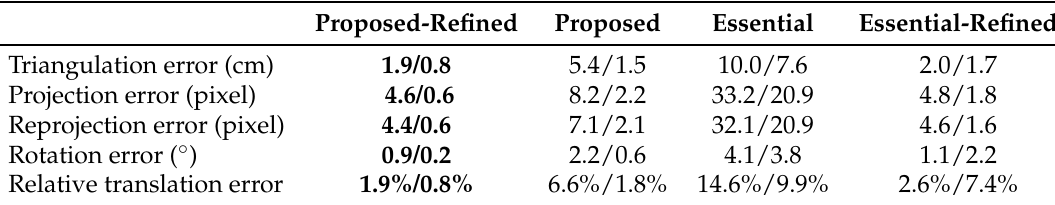
Table 2. Comparison of robustness against the uncertainty of detecting the head and feet in the image between our method (proposed) and the method of Hödlmoser et al. [17] (essential). The numbers are listed as “a/s”, where a is the average and s is the standard deviation over 100 experiments and 2 sets of techniques for detecting the head and feet. The number of locations is 8; each location yields 2 calibration samples (head and